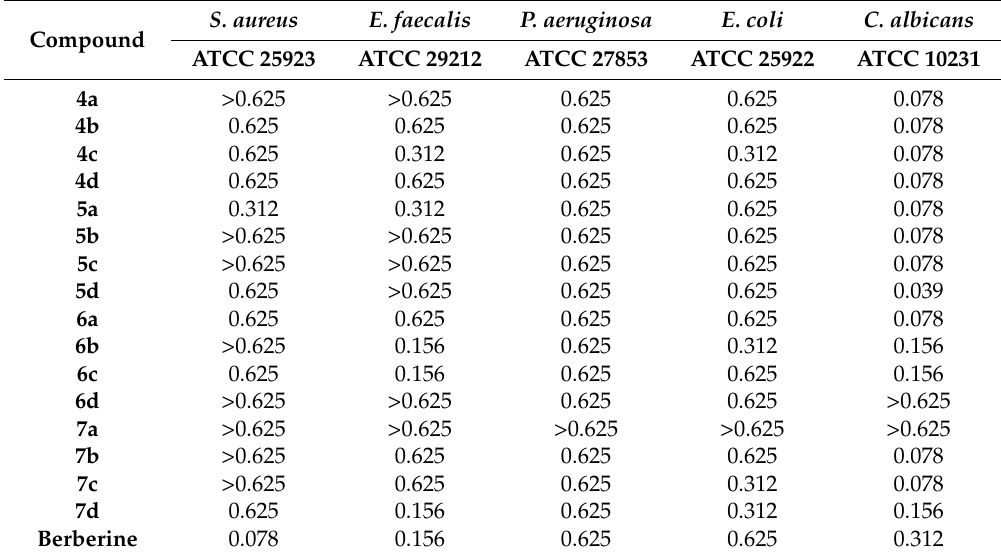
Table 3. The minimal biofilm eradication concentration MBEC (mg mL − 1 ) values of the final compounds against various microbial